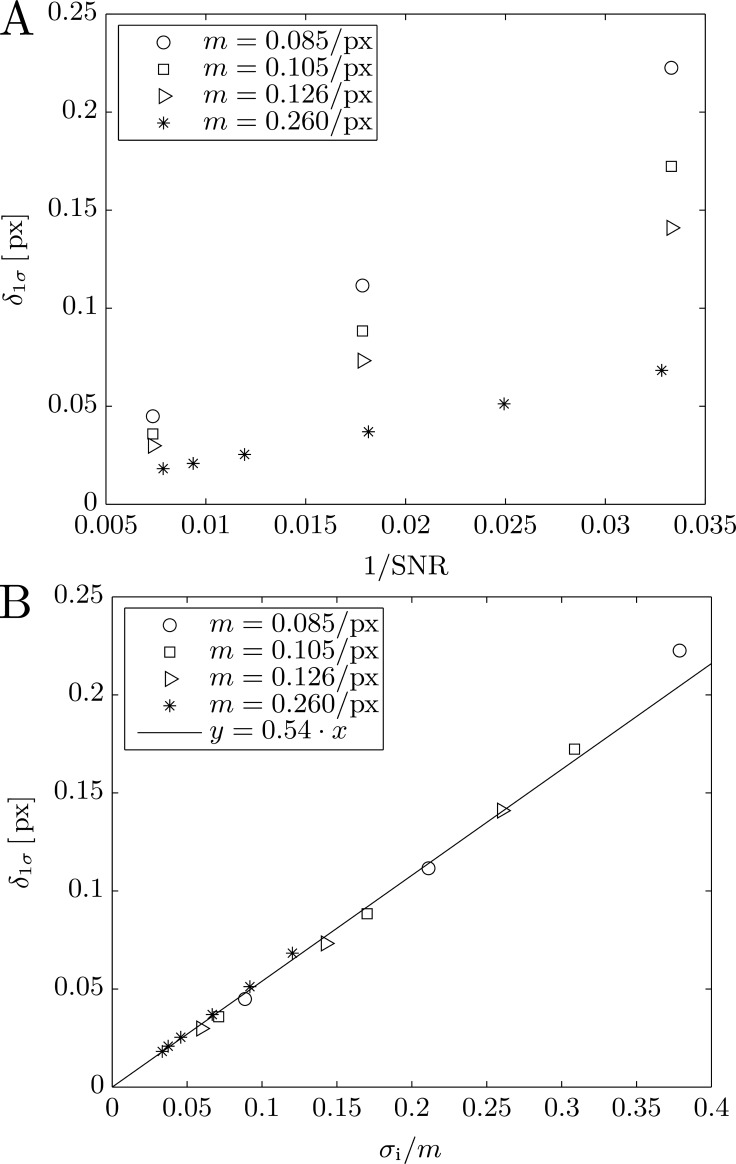
Segmentation precision depends on image noise and the slope of the intensity gradient.(A) Segmentation precision δ1σ versus 1/SNR for a dried RBC at different exposure times (‘*’) and for three synthetic datasets (‘□,○ and Δ’) with different level of contrasts/slopes m. The precision values from each dataset fall onto a straight determined by the contrast/slope m. (B) After renormalizing x-axis to σi/m all values fall onto a straight y = 0.54 ∙ x allowing for easy estimation of the segmentation precision from the two known quantities σi and m. Note that the contrast/slope values are for to unit background intensity.